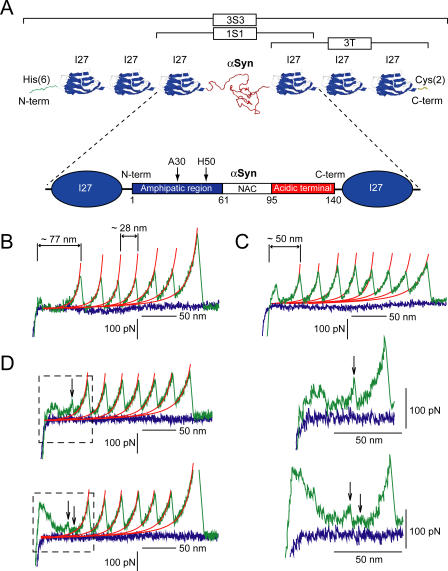
The Mechanical Signatures of αSyn Conformational Classes as Recorded by SMFS(A) Schematic representation of the polyprotein constructs used in this work: 3S3 contains the αSyn sequence (red) flanked on either side by three titin I27 modules (blue), the N-terminal His-tag needed for purification purposes (green), and the C-terminal Cys-Cys tail needed for covalent attachment to the gold surface (yellow). In 1S1, the αSyn moiety is flanked only by one I27 on both sides; the 3T is made up by three I27s. In the αSyn moiety (enlarged), three regions are shown: (i) the amphipathic region, prone to fold in α-helical structures when in contact with phospholipid membranes; (ii) the fibrillogenic NAC region, characteristic of the fibril core of αSyn amyloid; and (iii) the acidic C-terminal tail, strongly charged and not prone to fold. The positions of alanine 30, site of the A30P mutation and histidine 50, which is crucial for the binding of Cu2+, are marked.(B) Example of curve characterized by a featureless region assigned to the stretching of αSyn moiety having, in this case, the mechanical properties of a random coil (see Results section). This region is followed (from left to right) by six unfolding peaks of about 200 pN, with about 28-nm gaps between each, assigned to the unfolding of I27 domains.(C) Example of the curves featuring the β-like signature of αSyn (see Results section), showing seven practically indistinguishable unfolding events of similar magnitude and spacing.(D) Curves featuring the signature of mechanically weak interactions, showing single or multiple small peaks (arrows) superimposed on the purely entropic WLC behavior of the trace preceding the six saw-tooth–like peaks. The right panels show a zoom of the region enclosed by the dashed squares.